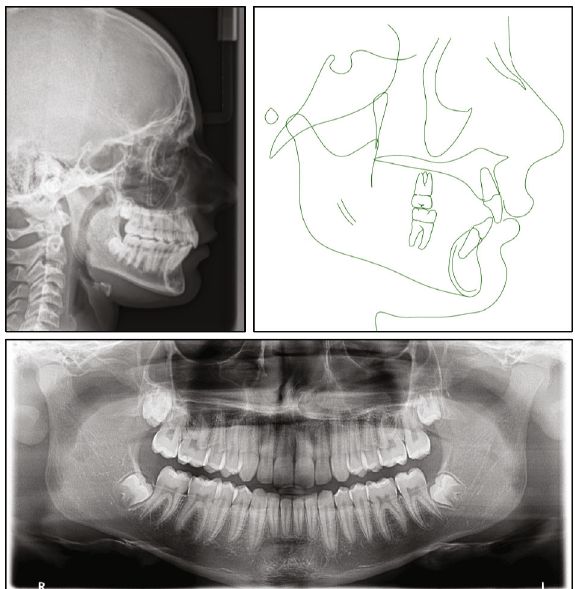
Figure 10: 1-year follow-up radiographs and